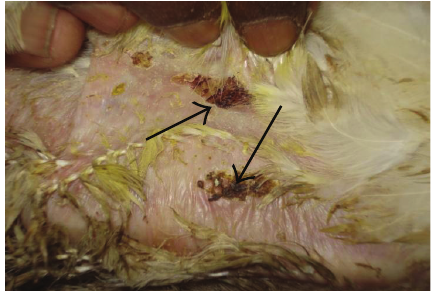
Figure 7: DTH reaction of skin (T-2 toxin plus SBT 800 ppm): moderate increase in skin thickness, ulceration, and scab formation compare to toxin-fed bird.